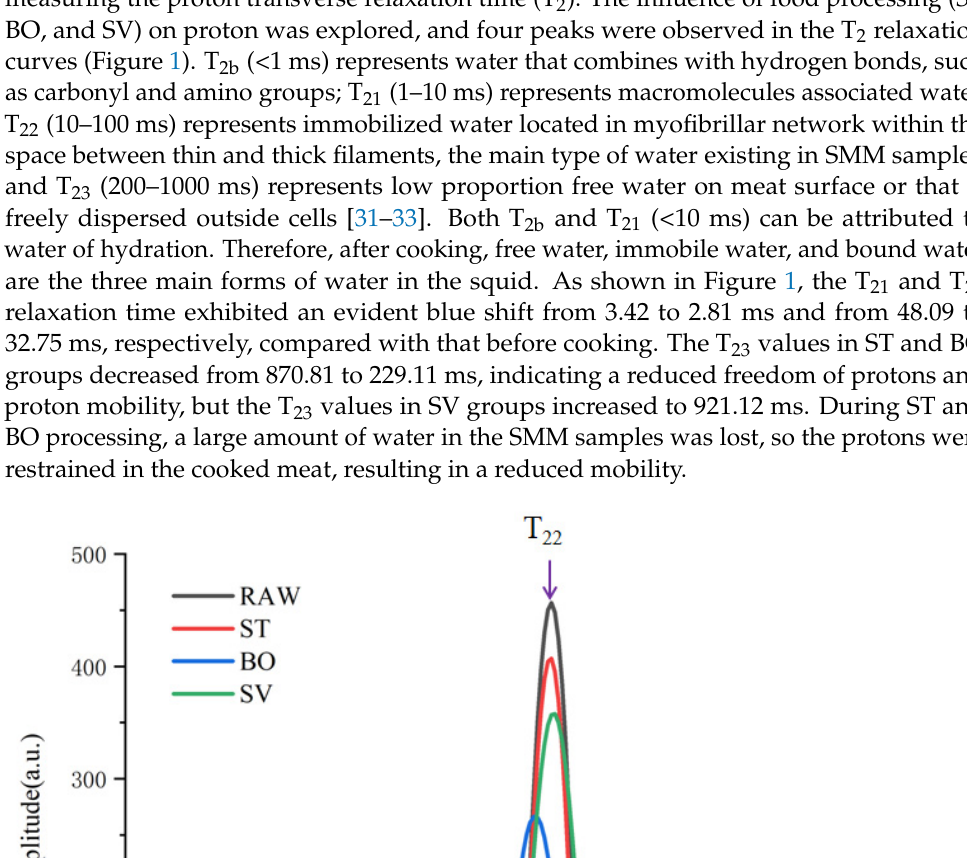
Figure 2. MRI images of the squid ( Symplectoteuthis oualaniensis ) mantle muscle with different cooking treatment. RAW: raw squid; ST: steaming; BO: boiling; SV: sous vide. The blue color in- dicates a lower proton density, while red color indicates a higher proton density.